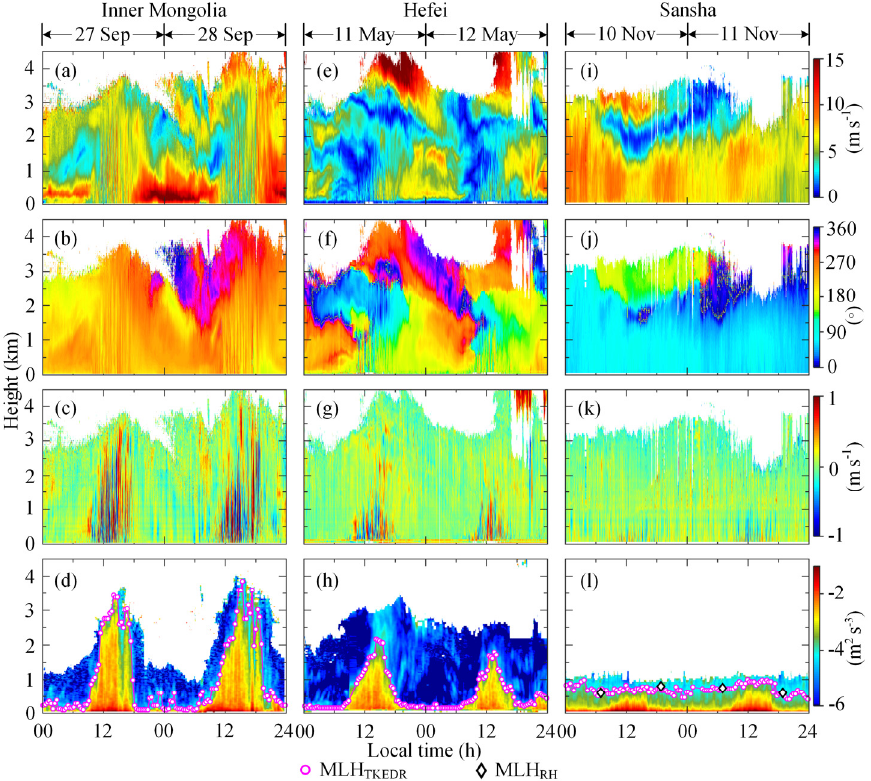
Figure 3. ( a ) Horizontal wind speed, ( b ) horizontal wind direction, ( c ) vertical wind speed, ( d ) lg(TKEDR) and its MLH retrieval result measured by ground-based CDWL during 27–28 September 2019 in Inner Mongolia. ( e – h ) is 11–12 May 2019 in Hefei. ( i – l ) is 10–11 November 2018 in Sansha. Horizontal wind direction is defined as 0° for northerly wind, rotating clockwise. Negative vertical wind speed denotes rising wind. Pink circle and black diamond denote CDWL-derived MLH TKEDR and radiosonde-derived MLH RH , respectively.